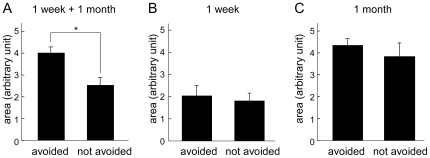
The relationship between the size of the PC and learning ability.(A) The size of the PC is larger in the slugs that showed odor-aversion (n = 45) than in the slugs that did not demonstrate aversion when the recovery period was not considered (n = 30). *P<0.005 by Student's t-test. (B) There is no difference in the size of the PC between slugs that showed odor-aversion (n = 6) and slugs that did not show such aversion (n = 19) in the 1 week recovery group. (C) There is no difference in the size of the PC between the slugs that showed odor-aversion (n = 39) and those that did not show such aversion (n = 11) in the 1 month recovery group.